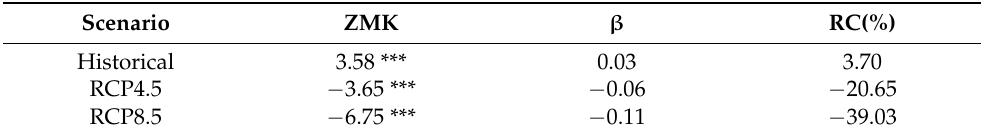
Table 4. Statistics of the Mann-Kendall test (ZMK) and the magnitude of trends approximated by Sen’s estimator ( β ) for the De Martonne aridity index (I DM ), considering the historical period and all years until the end of the 21st century for each scenario. RC is the relative change.